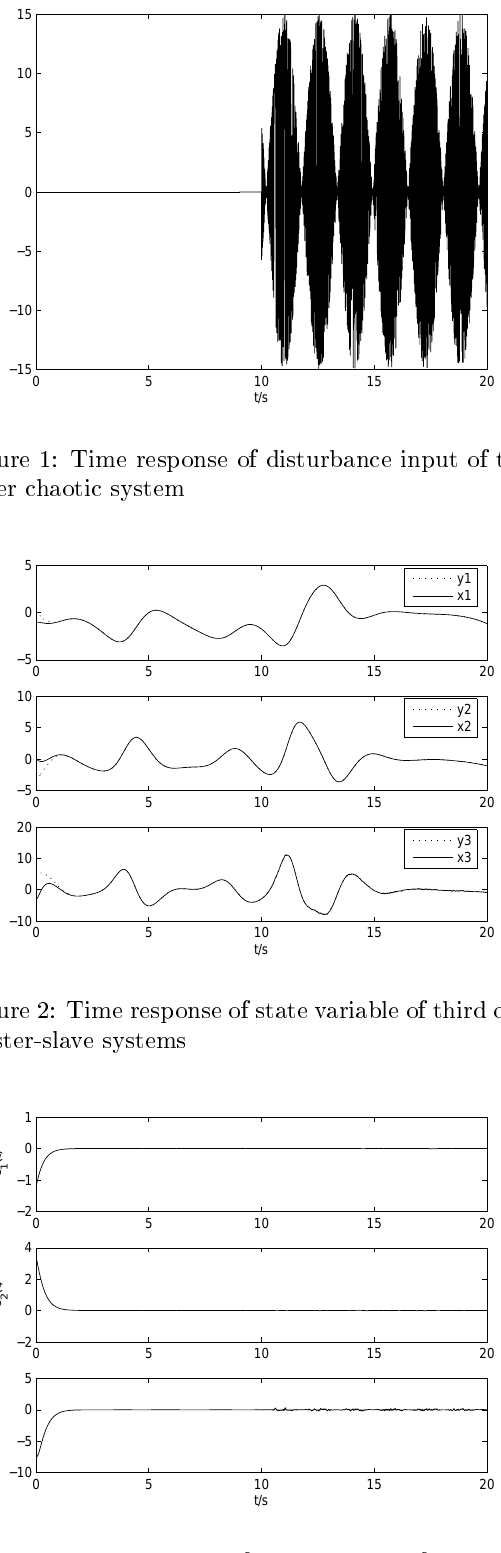
Figure 3: Time response of error variable of third order master-slave